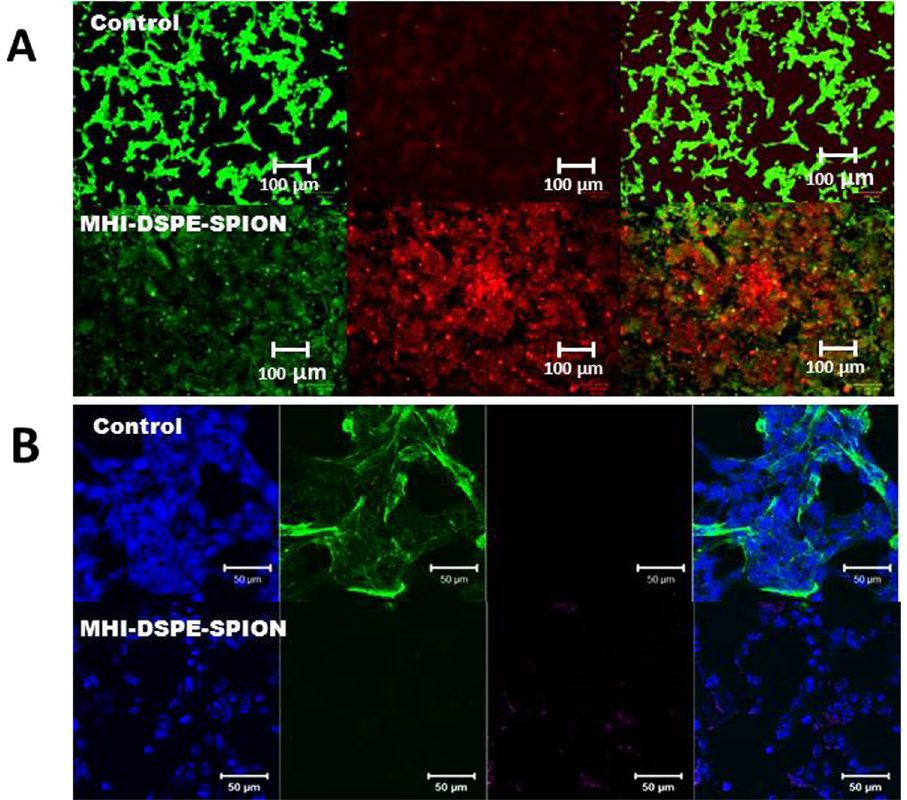
Figure 10. Cell survival of SCC7 cells after incubation and photothermal treatment. ( A ) Qualitative evaluation, by FDA/PI staining, of cell survival upon treatment with MHI-DSPE-SPION plus laser irradiation. Fluorescence images of SCC7 cells after photothermal treatment. Viable cells were stained green with FDA. Dead/later apoptosis cells were stained red with PI. ( B ) Cell actin and nuclei were stained by Alexa 488-labelled secondary antibody binding to the α -sma primary antibody and DAPI, respectively. Control SCC7 cells showing actin expression indicate cell attachment. The MHI-DSPE-SPION-treated SCC7 cells after photothermal treatment show minimal actin expression due to cell